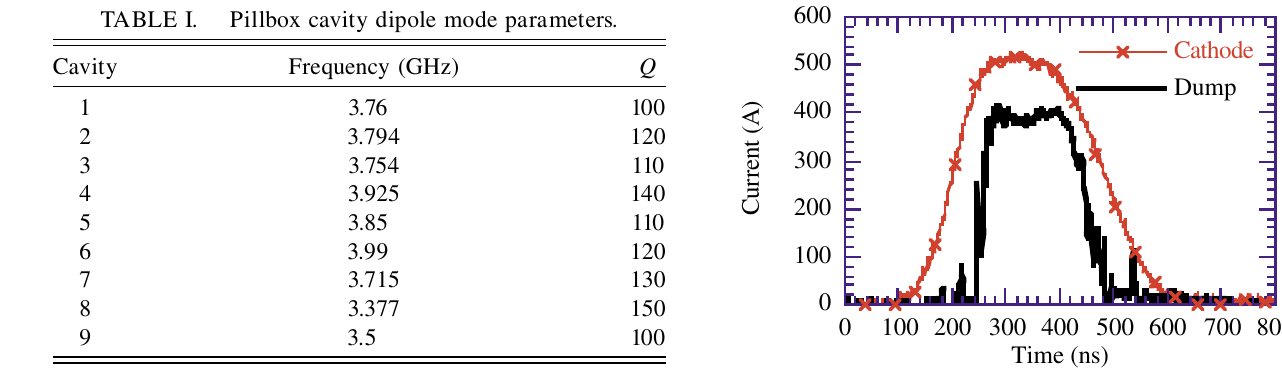
FIG. 6. (Color) Typical cathode and dump current pulses.